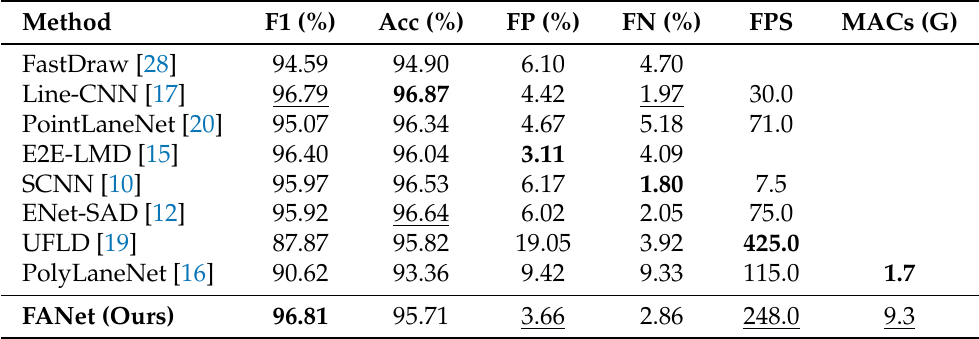
Table 3. State-of-the-art comparisons on TuSimple. For fair comparison, frames per second (FPS) was measured on the same machine used by our method. The best and second-best results across methods are shown in boldface and underlined, respectively. These blank values indicate that the results are not published in their papers, and their codes and models are not available either.